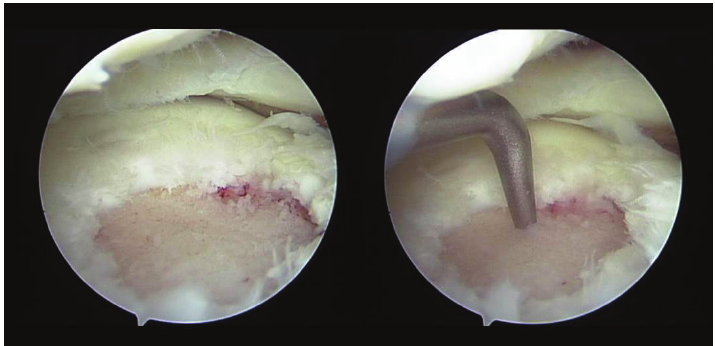
Figure 4: Arthroscopic findings: the damaged cartilage was curetted, and microfracture was performed. An awl with the tip bent 90 ∘ was used to perforate the bone at 3 to 4 mm intervals.